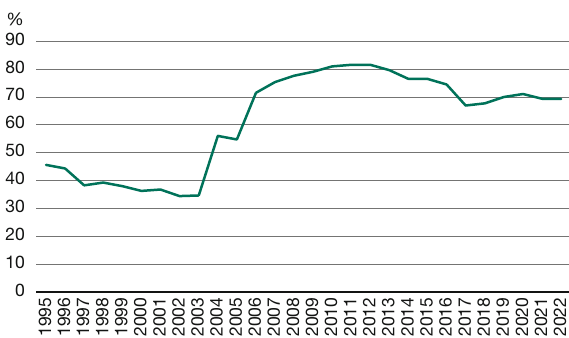
Source: State Statistics Service of Ukraine and National Bank of